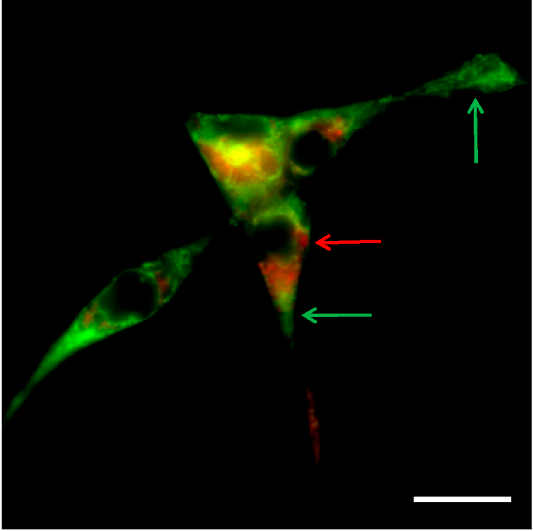
Figure 9. Comparative distribution of mitochondria labeled with Mitotracker Green FM (MTG) and/or Mitotracker Red CMXRos (MTR) in living PC12 cells. PC12 cells were incubated simultaneously for 30 min at 37 °C with 10 µM of MTG and 10 µM of MTR. Overlay shows MTG staining in green and MTR in red color through wide-field microscopy imaging (X63 oil immersion objective). Green and red arrows indicate mitochondria exclusively labeled with MTG or MTR respectively. Scale bar: 20 µm.